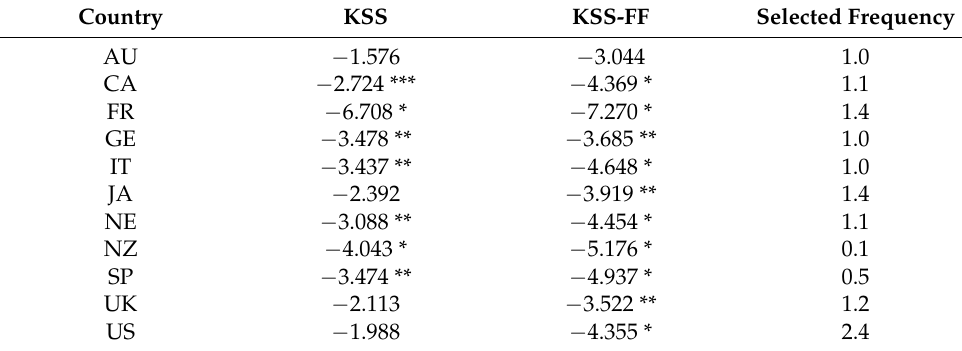
Table 7. Eleven OECD real interest